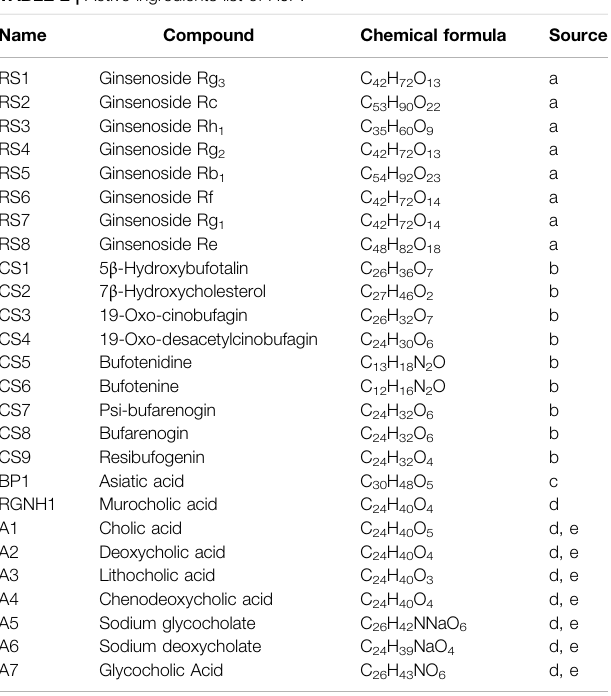
TABLE 2 | Active ingredients list of